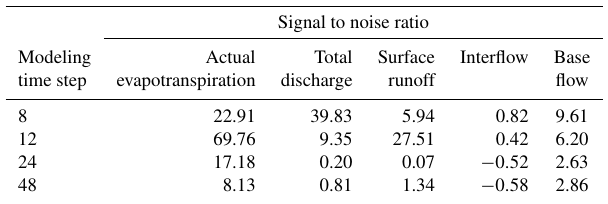
Table 3. Signal-to-noise ratio for different modeling time steps. Signal refers to LULC change effect, and noise is soil refinement